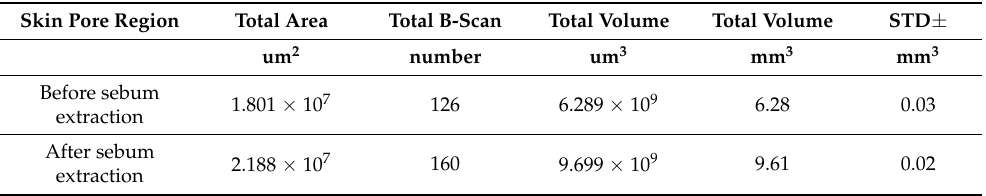
Figure 5. Pixel-by-pixel representation of the volume calculation from the OCT images. ( a ) X-Y plane of a single image; ( b ) selecting multiple images for the calculation of the surface area; ( c ) summation of the surface area from each image plane and ( d ) calculating the volume from the surface area. The calculated value of the skin pore and hole volume are shown in Table 1. The images used before and after the sebum extraction are 126 and 160, respectively. The volume calculated was 6.28 mm 3 and 9.61 mm 3 for the skin pore and hole, respectively. This evaluation can be useful for analyzing various wound healing processes in addition to the different treatment interventions. Table 1. Measurement of the total volume before and after the sebum extraction. Skin Pore Region